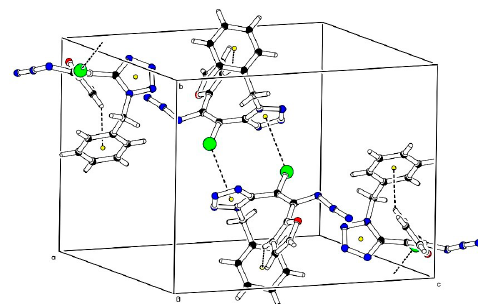
Figure 2. Crystal packing of 7h showing the network of C–H···Cg and Br–Cg interactions. Table 1. Selected bond distances (Å), bond angles ( ° ) and torsion angles ( ° ) for compounds 7c , 7h and 7e . Atom X is either Cl ( 7c and 7e ) or Br ( 7h ).